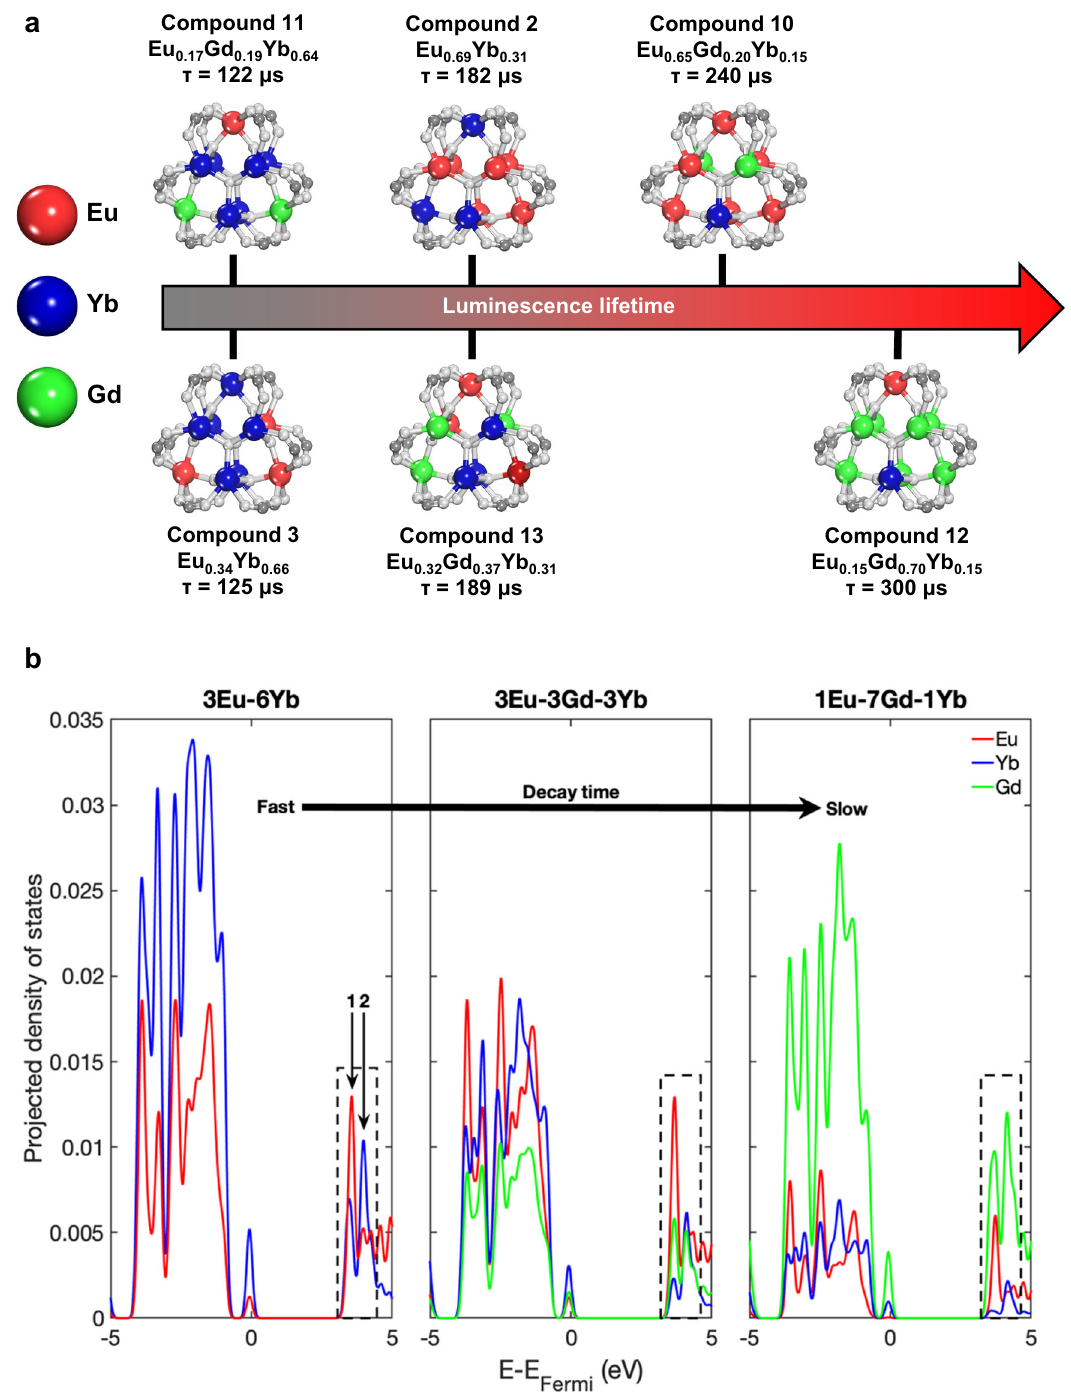
Fig. 5| Informationregardingmetaldistributionanditseffect onthereported MOFs. a Illustration of the effect of composition on visible lifetime for different compounds. The lifetime of a compound is determined by the probability of a Yb metal center (blue sphere) neighboring an Eu metal center (red sphere) and receivingenergyfromit.ThepresenceofaGdmetalcenter(greensphere)reduces theprobabilitythatanEucenterwillhaveaneighboringYbcenter. b CalculatedRE PDOS near the electronic band edges for three representative heterometallic